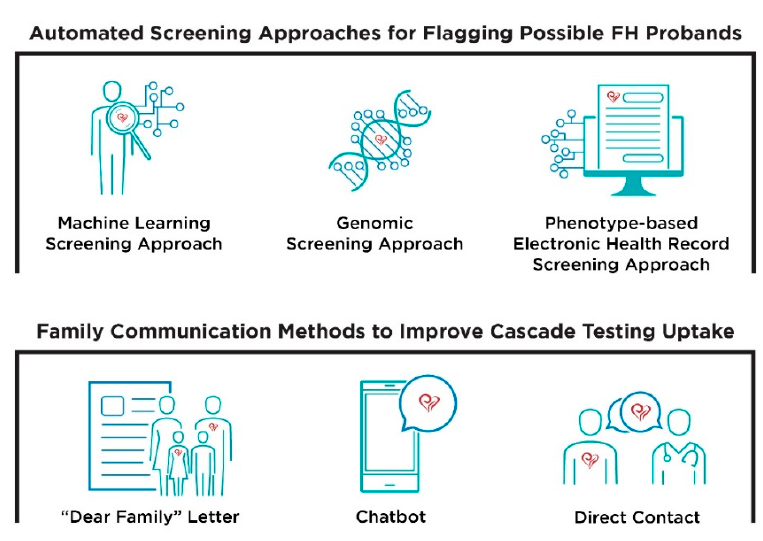
Figure 1. Visualization of the initiatives presented to stakeholders during focus groups.